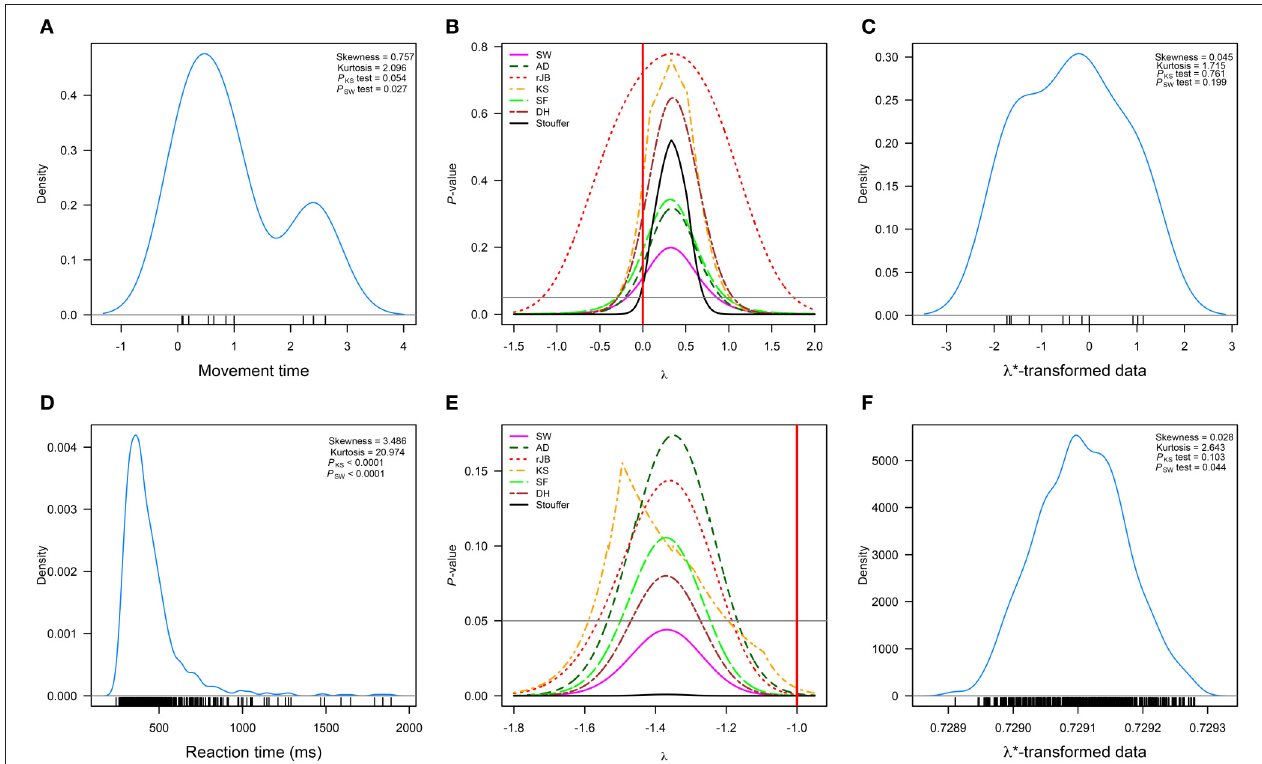
FIGURE 2 | Published data sets in which the Box–Cox transformations was used. (A–C) correspond to the data ( n = 13) analyzed in Salowitz et al. [37]; (D–F) to a set of observations ( n = 917) analyzed in Marzouki et al. [38]. (A,D) correspond to the real data; (B,E) to the p -values of six normality tests and the Stouffer method as a function of λ ; and (C,F) to the λ * combined − transformed data sets. The horizontal line represents α = 0.05 , and the red vertical line the value of λ used by the researchers. Measures of skewness and kurtosis are also shown along with the p -values of the Kolmogorov–Smirnov ( P KS test) and Shapiro–Wilk ( P SW